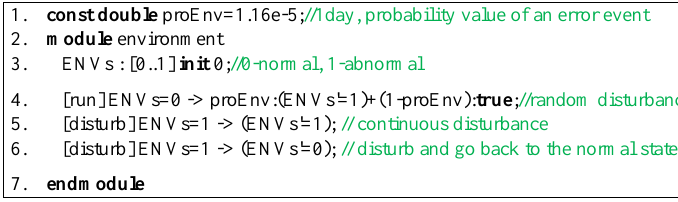
Figure 7. The PRISM-games model of environment